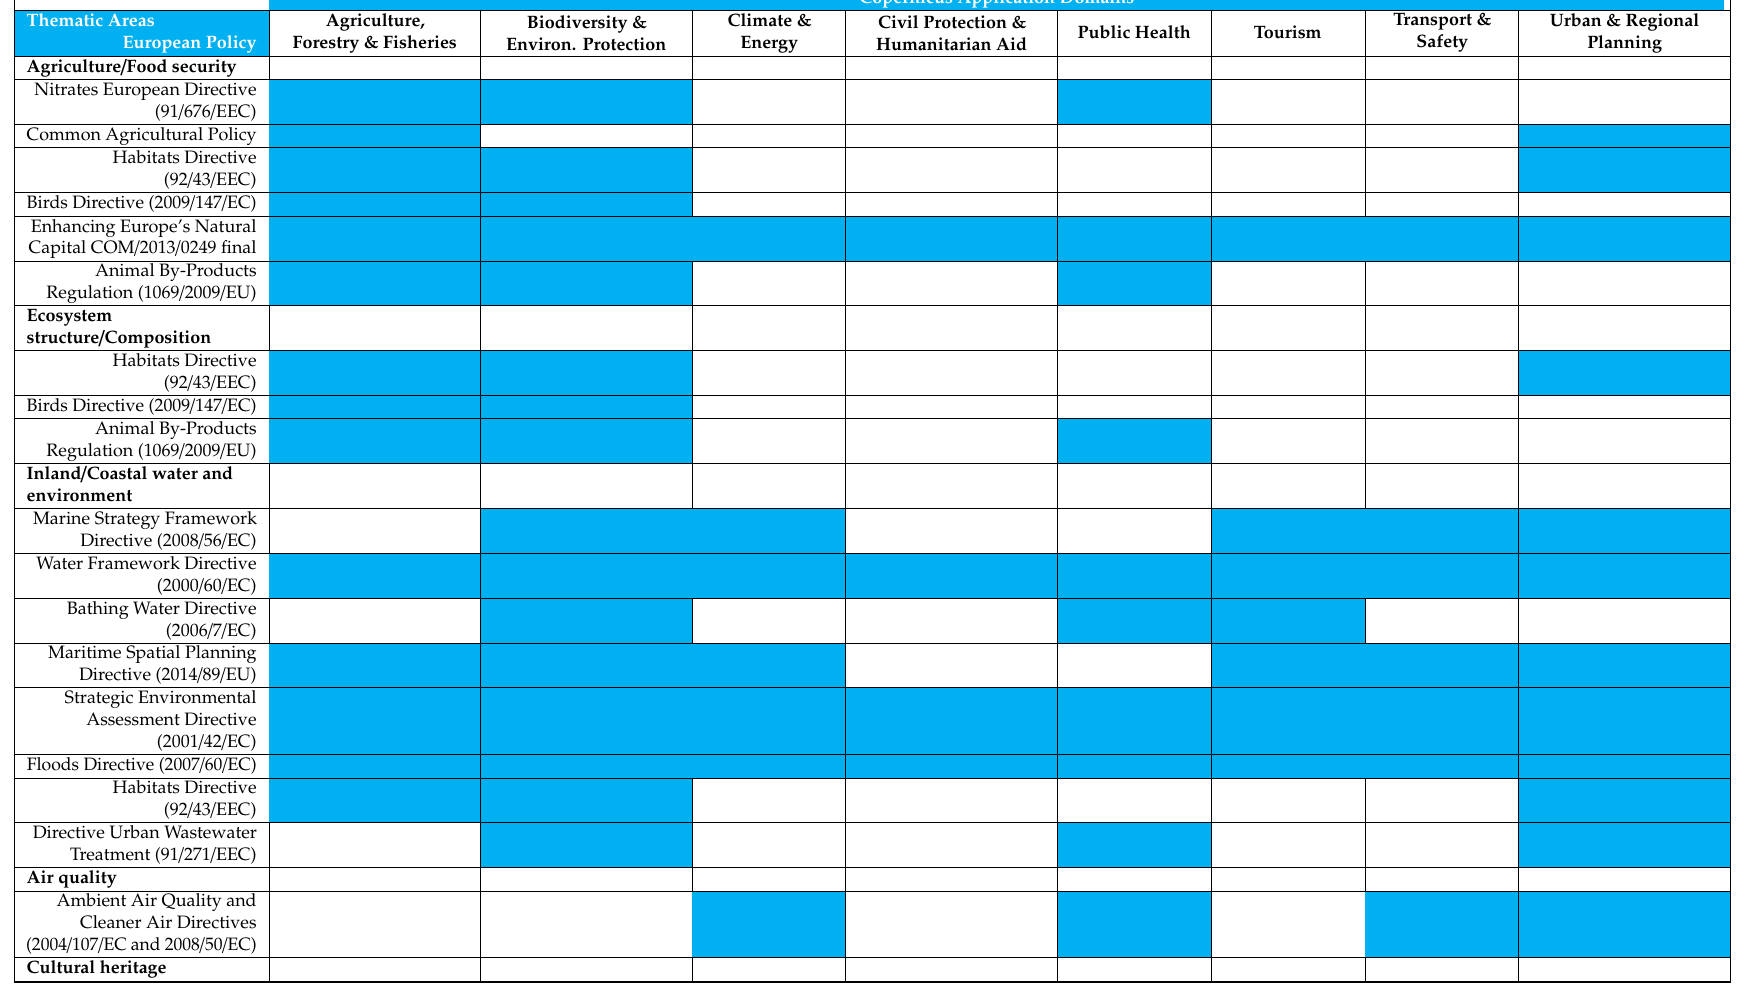
Table 3. Copernicus Application Domains versus European Union legal acts and